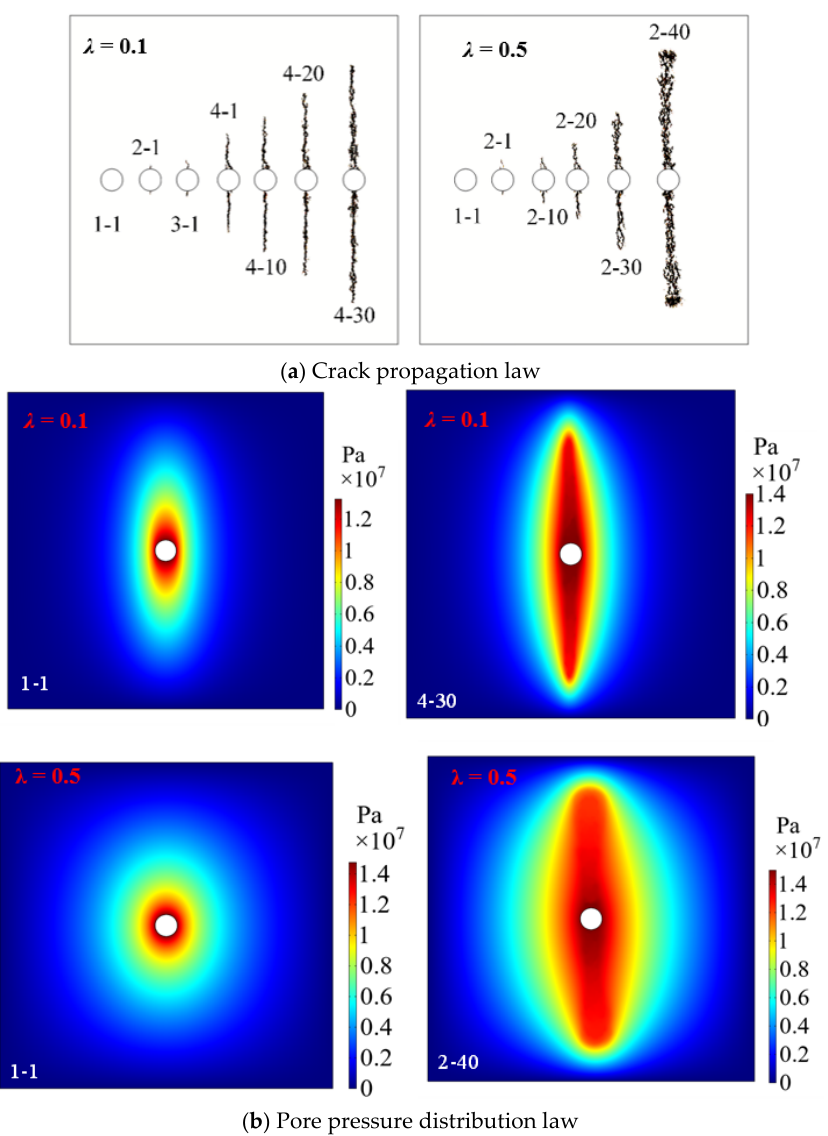
Figure 10. Crack propagation and pore pressure distribution law under different λ .